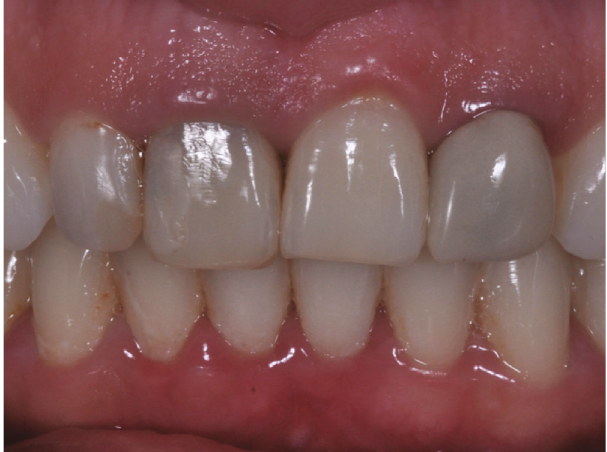
Figure 1: Initial clinical image of the case.